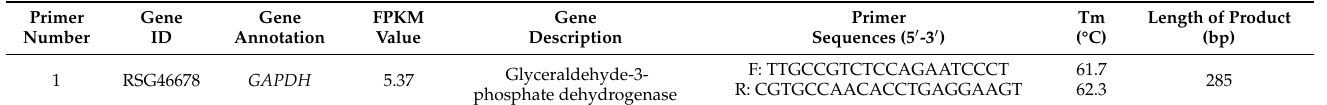
Table 1. Selected candidate reference genes and their respective PCR